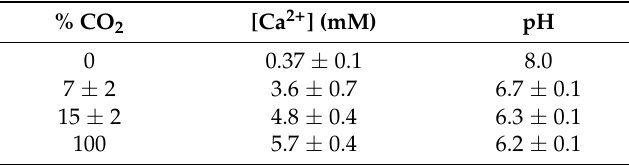
Figure 1. Changes in pH and calcium concentration with time in potable water mixed with CaCO 3(s) while in contact with 100% CO 2 gas at room temperature. Table 1. Effect of percent CO 2 on the equilibrium [Ca 2+ ] and pH of saturated Ca-CO 3 -potable water solutions.